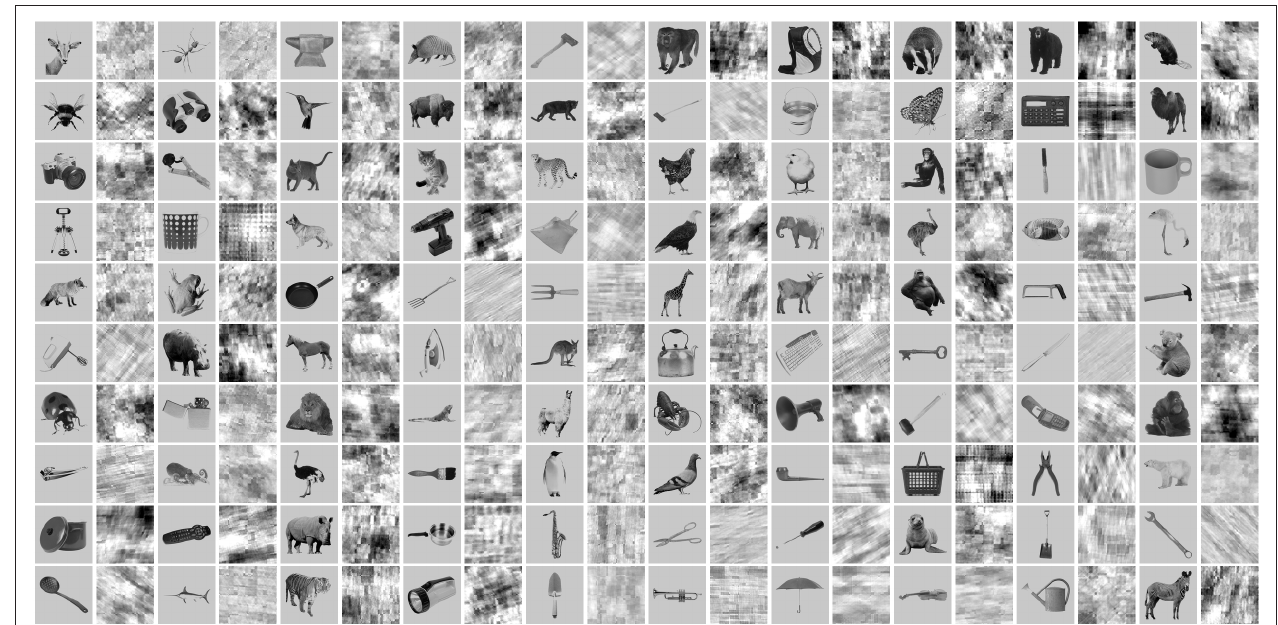
FiGurE 1 | The set of 200 stimuli used in the experiments: 50 animals, 50 tools, and 100 phase-scrambled